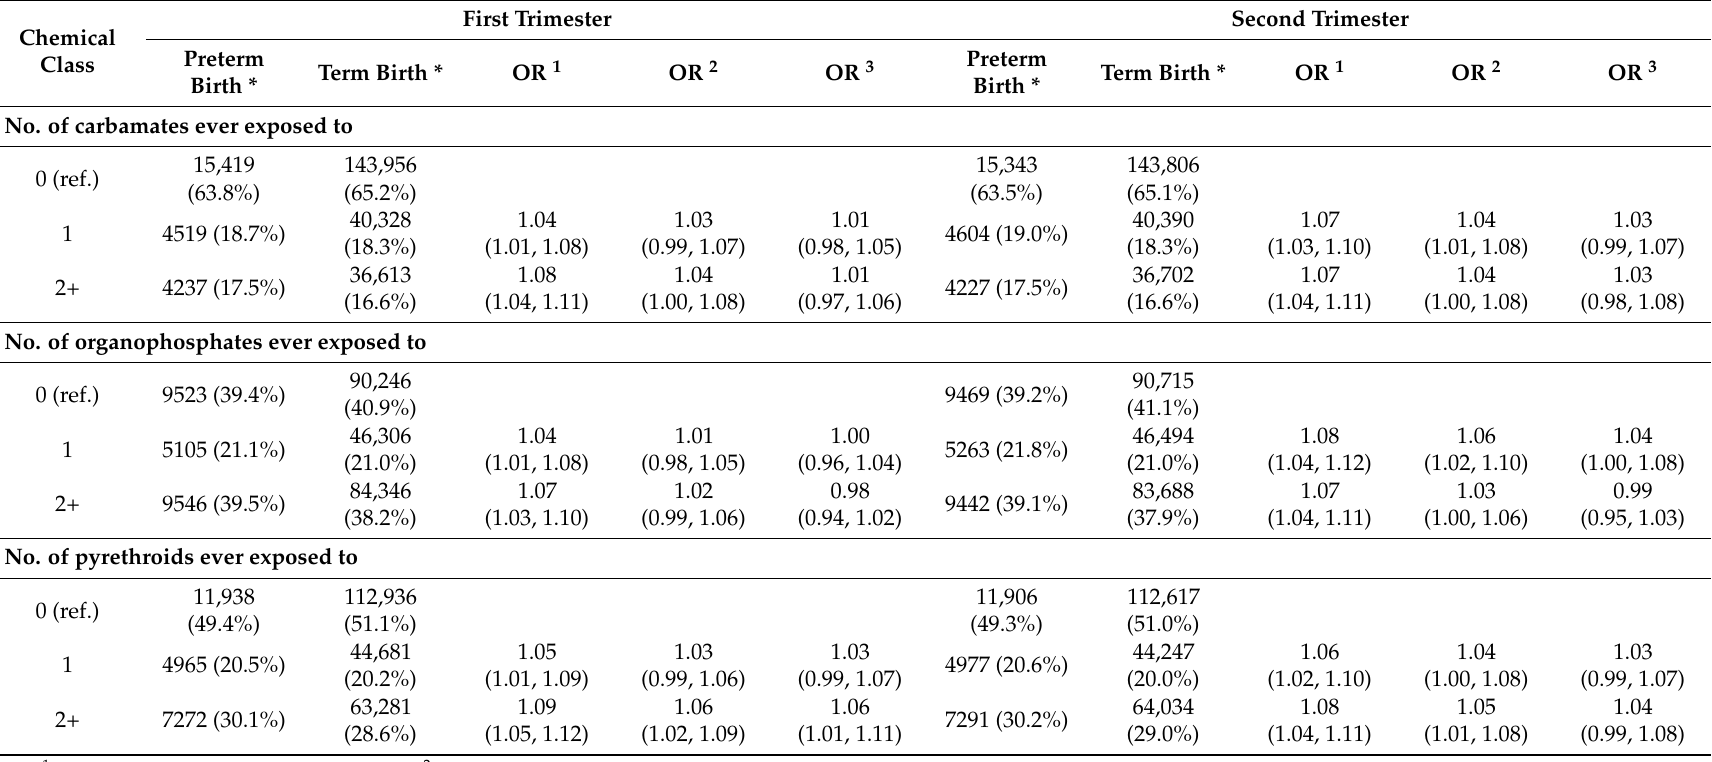
Table 3. Odds ratios (95% confidence intervals) for trimester exposures to chemical classes and preterm